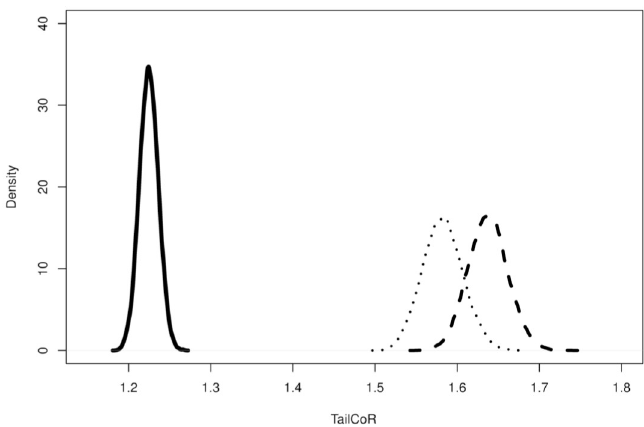
Fig 5. TailCoR for different distributions. Distribution of 10000 estimated TailCoR’s for ξ = 0.95 and three distributions: Gaussian (solid line), Student- t with α = 2.5 (dashed line), ES with α = 1.5 (dotted